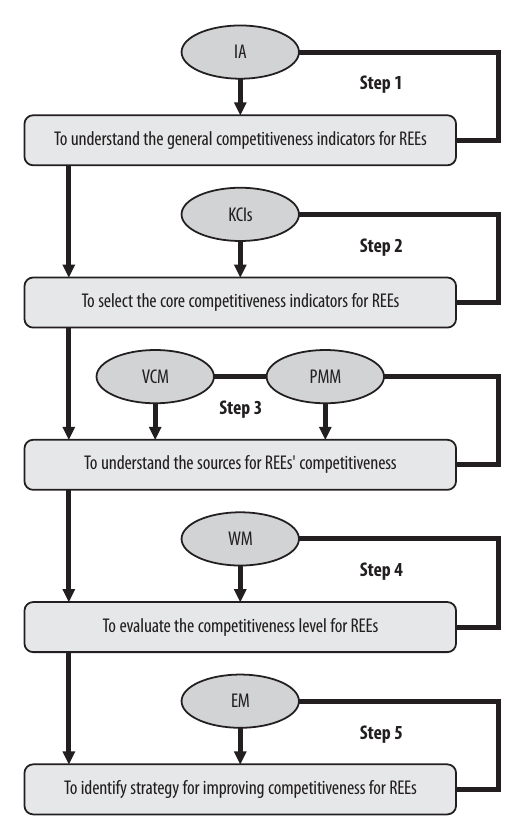
Figure 3. A model-procedures for assessing REEs’